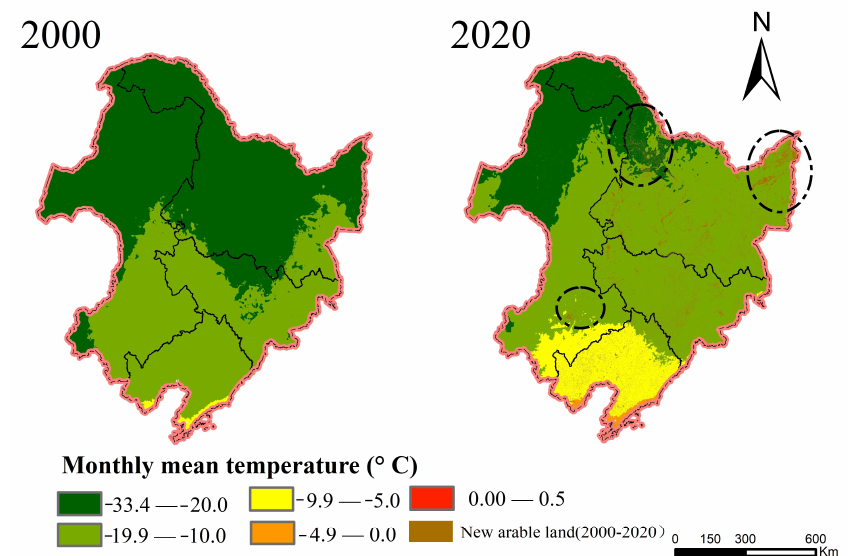
Figure 5. Monthly mean temperature pattern changes.